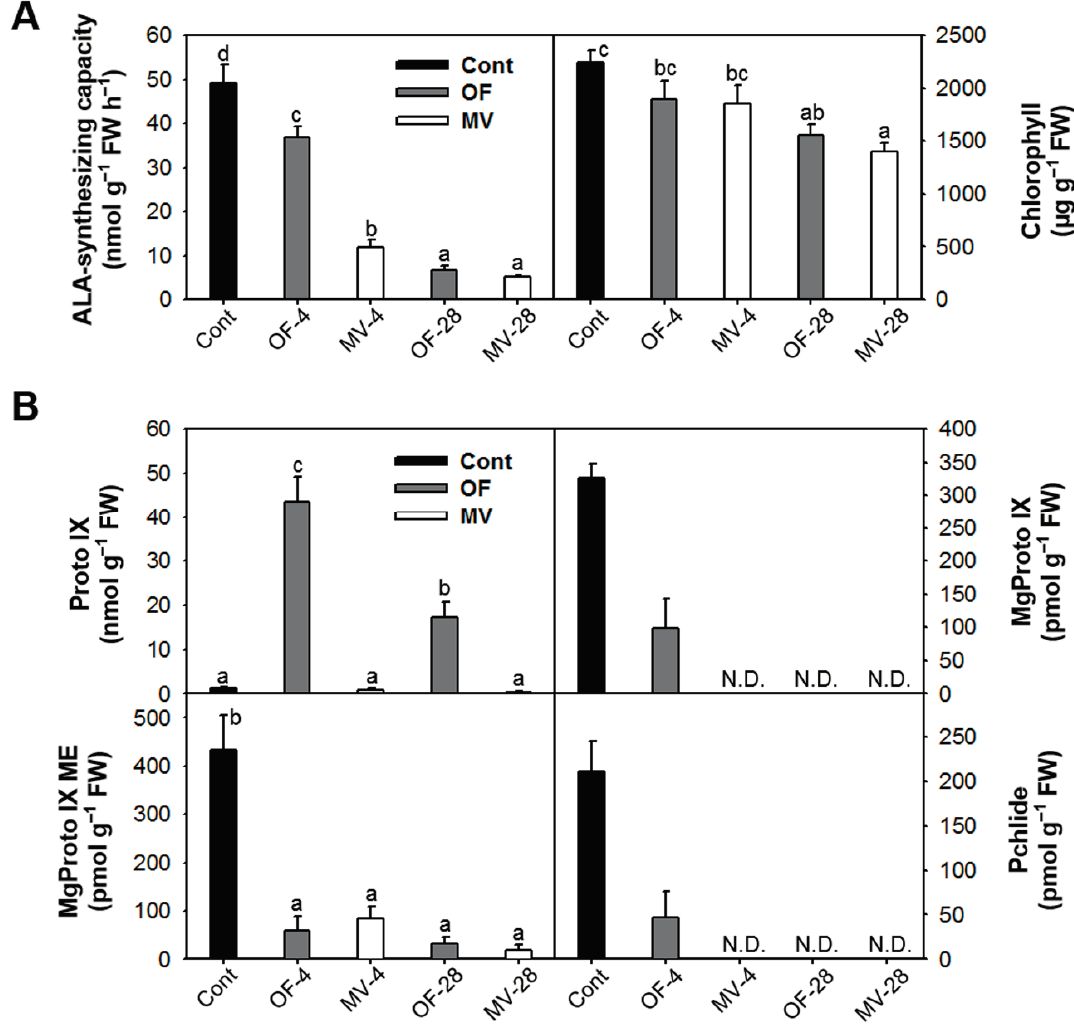
Figure 5. Changes in intermediates of porphyrin biosynthetic pathway in rice plants with the foliar application of OF or MV. ( A ) 5-aminolevulinic acid (ALA)-synthesizing capacity and chlorophyll content; and ( B ) Protoporphyrin IX (Proto IX) and Mg-porphyrin intermediates. The plants were subjected to the same treatments as in Figure 2. Treatment notations are the same as in Figure 2. N.D., not detected. The data represent the mean ± SE of six replicates from two independent experiments. Means denoted by the same letter did not differ significantly at p < 0.05 according to LSD test. Different letters indicate significant difference in